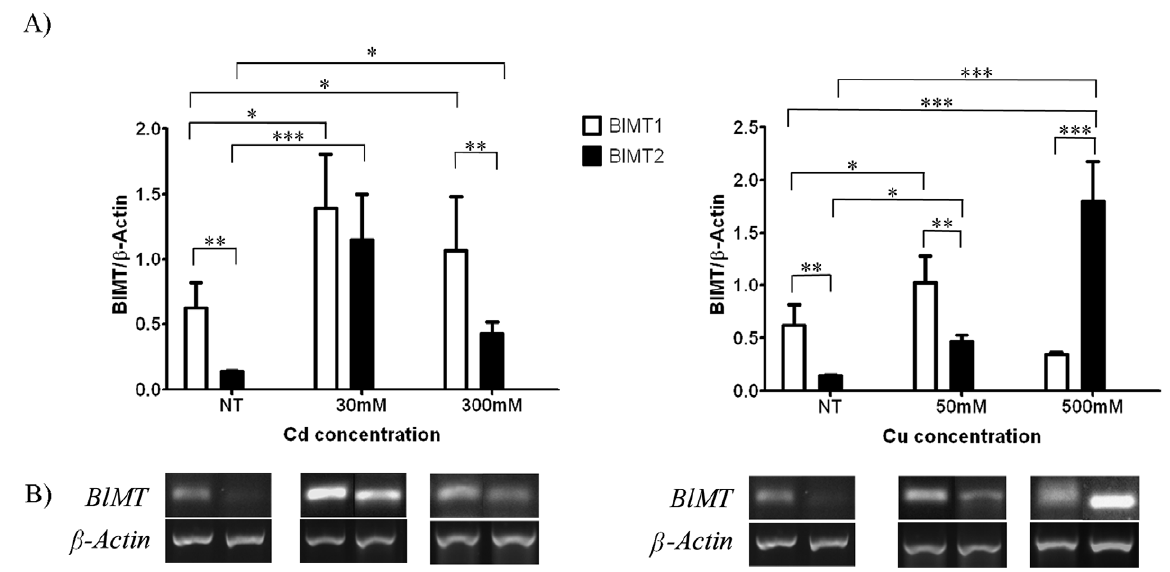
Figure 5. BlMT1 is essentially constitutive, while BlMT2 is an inducible gene, as revealed in metal and non-metal treated B. lanceolatum organisms. ( A ) Semi quantification by RT-PCR of transcription rates under Cu and Cd supplementation, and statistical comparison. Data for each gene and condition is normalized by the corresponding value for the constitutive gene b -actin , previously homogenized between organisms and groups. Data represent mean and standard deviation of six organisms. Significance was assessed using the Newman-Keuls statistical test. Stars denote statistical significance as follows: * as equivalent to a significance of P , 0.05, ** equivalent to P , 0.01, and *** to P , 0.001. B) Best examples of RT-PCR bands representing the results observed in A). NT stands for non-treated